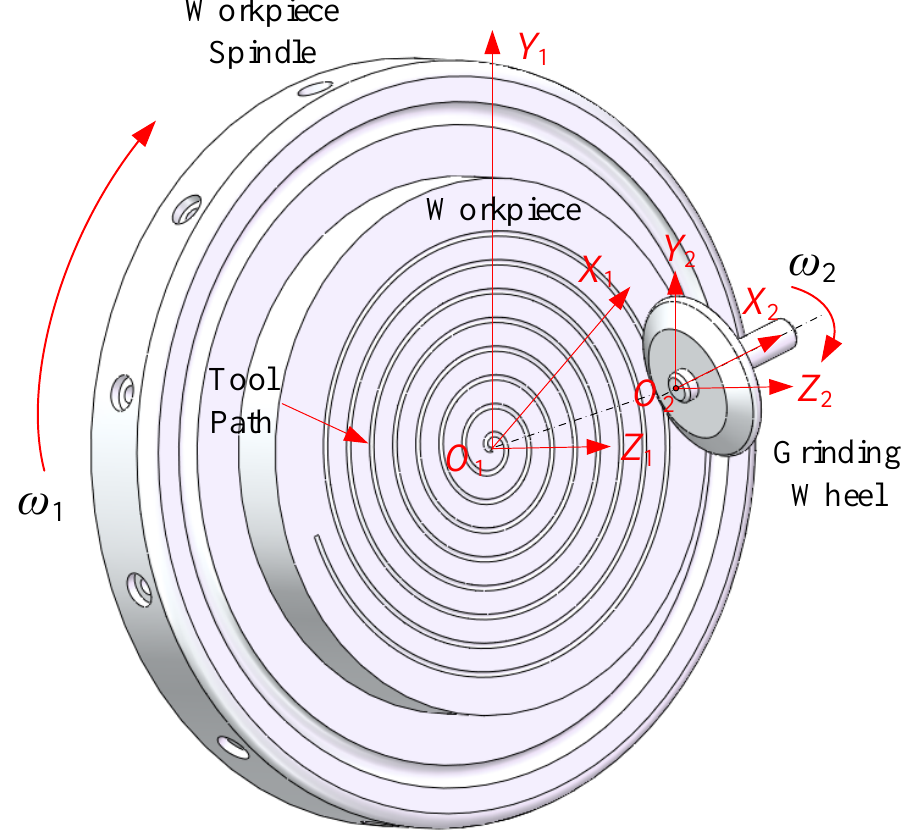
Figure 1. Schematic diagram of ultra-precision parallel grinding.